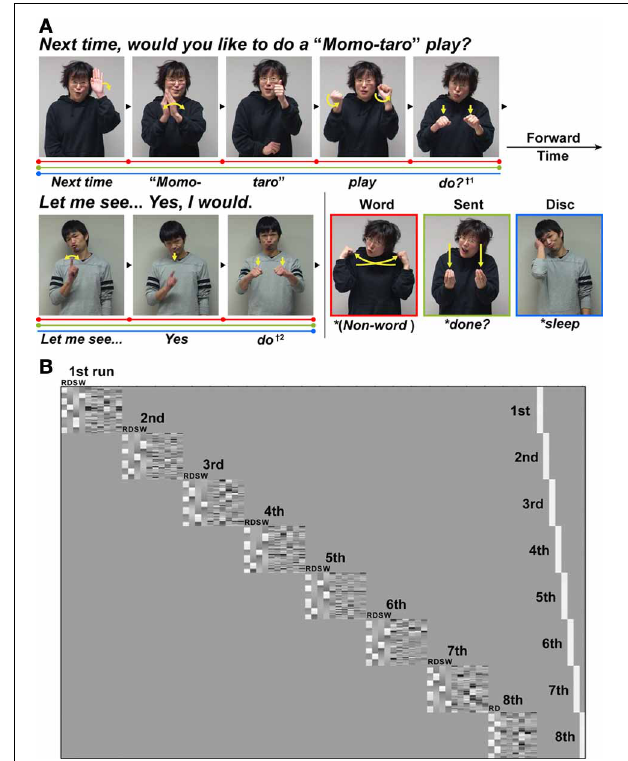
FIGURE 1 | An experimental paradigm with language tasks in Japanese Sign Language (JSL). (A) There were three language tasks: a word-level decision (Word), a sentence-level decision (Sent), and a discourse-level decision (Disc) task. The stimuli used in the Disc task were a long dialog articulated by two signers who were taking turns (see Table 1 ). In both the Word and Sent tasks, the sentences from this dialog were presented in a randomized order. In these three language tasks, some words or phrases were replaced with anomalous probes (indicated by asterisks before the translated words in the figure), to which the participants were asked to respond by pressing a button. For example, in the Word task, the word “ do? ” (denoted by † 1) articulated by the first signer was replaced by a pseudo-sign (the picture with a red border). In the Sent task, the word “ do? ” was replaced by a syntactically anomalous JSL sign “ done? ” (the picture with a light green border) as a perfective aspect marker expressing the past tense. In the Disc task, the word “ do ” (denoted by † 2) articulated by the second signer was replaced by a contextually anomalous sign “ sleep ” (the picture with a blue border). The linguistic units for these three tasks are shown in color bars separated by dots: Word (red), Sent (light green), and Disc (blue). (B) The general linear model design matrix for one typical participant. Run-specific predictors are shown in the right-hand columns (denoted as 1st–8th) that model differences among individually averaged activations in eight runs. For each of the left-hand columns representing the first to seventh runs, the regressors of the R, Disc (D), Sent (S), and Word (W) tasks (convolved with a hemodynamic function), as well as the realignment parameters of three translations and three rotations obtained from preprocessing (i.e., due to head movements), were included in the design matrix in this order. For the eighth run, the regressors of the R and Disc tasks, as well as the six realignment parameters, were included in the design